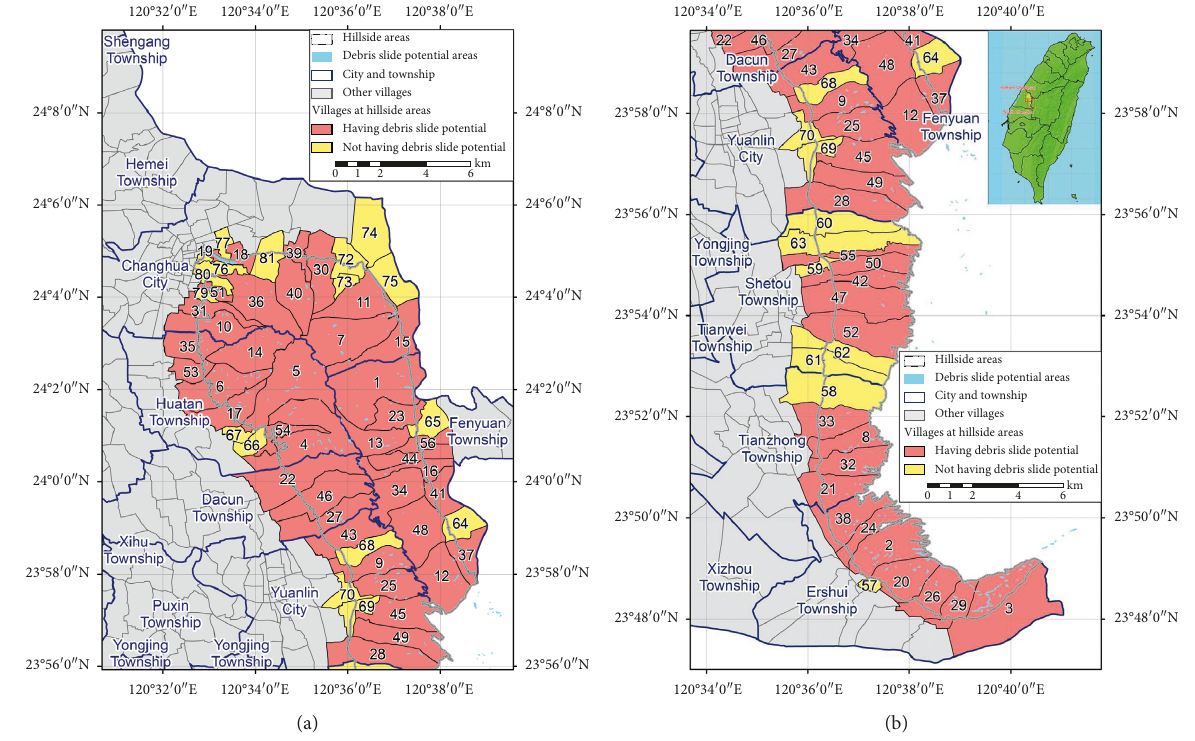
Figure 1: Distribution map for hillside villages in Changhua County: (a) northern Changhua; (b) southern